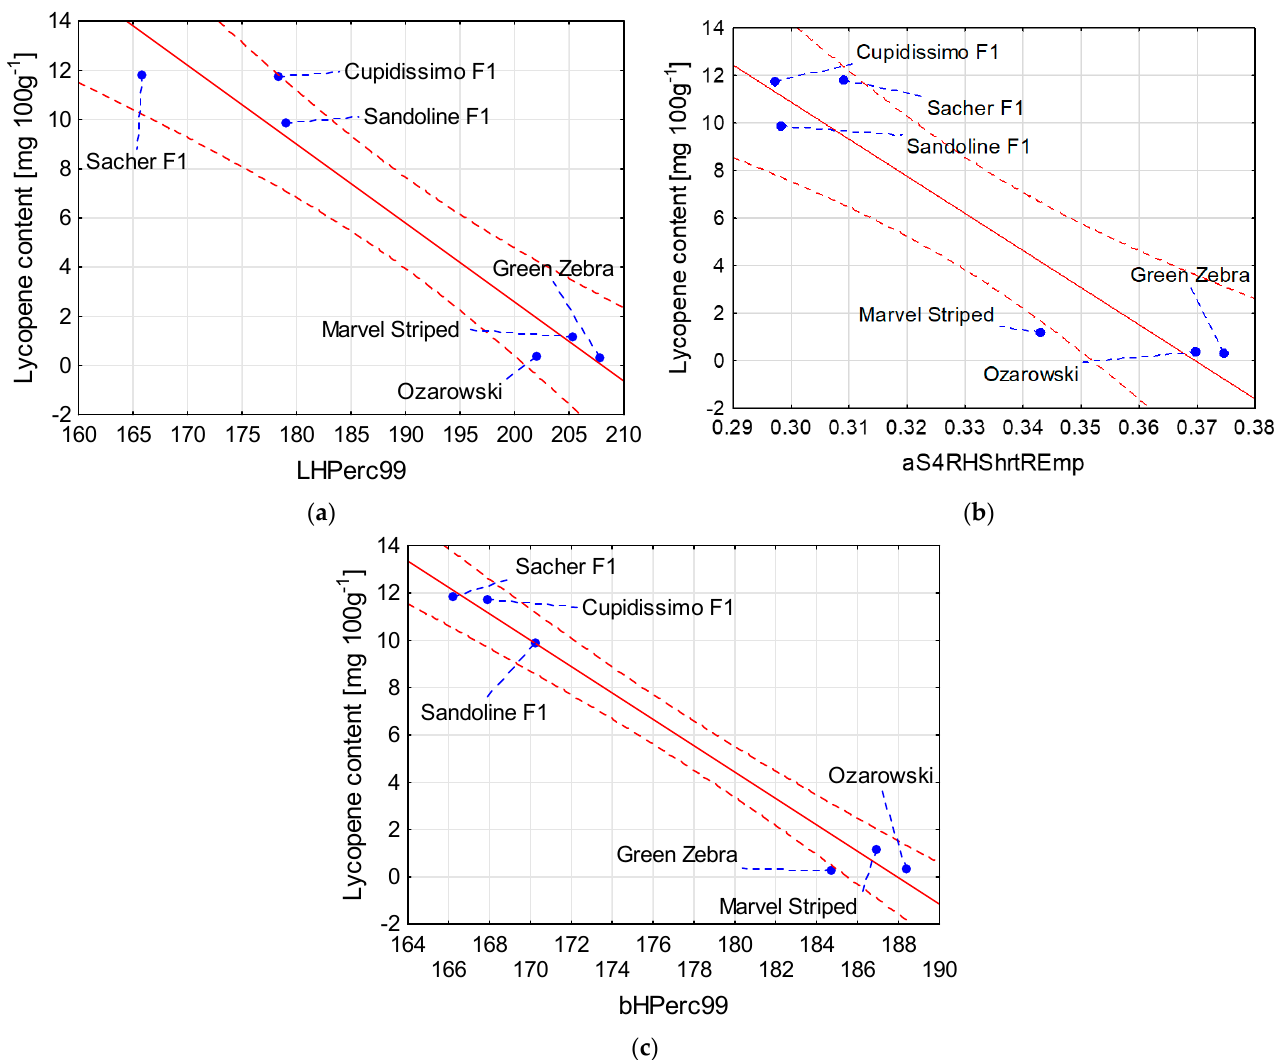
Figure 5. Scatter plots for lycopene content (mg 100 g − 1 ) and selected image textures: LHPerc99 ( a ), aS4RHShrtREmp ( b ) and bHPerc99 ( c ) from Lab color space of tomato fruit. Blue dot—mean value for the sample; blue dashed line—line connecting the mean value to the sam- ple name; solid red line—regression line; red dashed line—confidence interval (95%) The correlation coefficients between lycopene content and textures from XYZ color space (Table 4) were very high, reaching − 0.99 for YHVariance from color channel Y . The highest positive correlation was 0.98 and also belonged to color channel Y (YHMaxm10). In the case of color channels X and Z , only two textures were statistically significantly correlated with lycopene content. The R parameter reached − 0.98 for XHVariance and − 0.93 for ZHDomn01. The highest correlations between lycopene content and textures from XYZ color space for textures from the color channels X and Y were confirmed by scatter plots, shown in Figure 6. Table 4. Correlation coefficients (R) between lycopene content (mg 100 g − 1 ) and selected image tex- tures from XYZ color space of ‘O ż arowski’, ‘Marvel Striped’, ‘Green Zebra’, Sandoline F1, Cupidis- simo F1, and Sacher F1 tomatoes; p < 0.05.